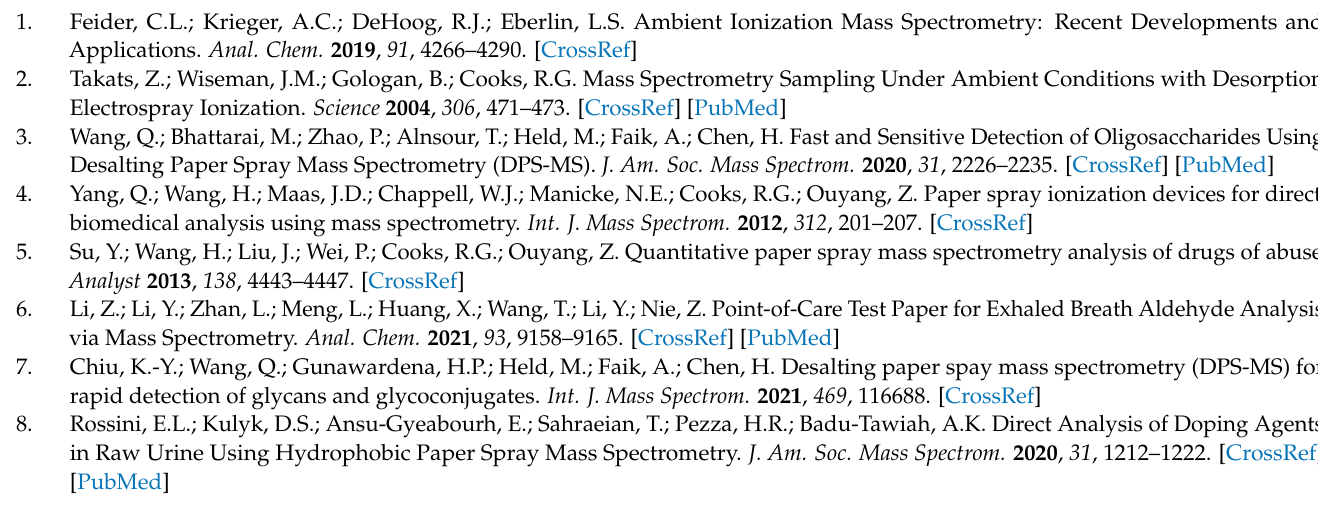
Figure S3: CID-MS/MS spectra of morphine, and norcodeine, Tabls S1: List of isobaric ions that were frequently detected in saliva or serum and successfully distinguished by HDX-CPSI-MS, Table S2: List of isobaric ions that were frequently detected in biological fluids and successfully distinguished by